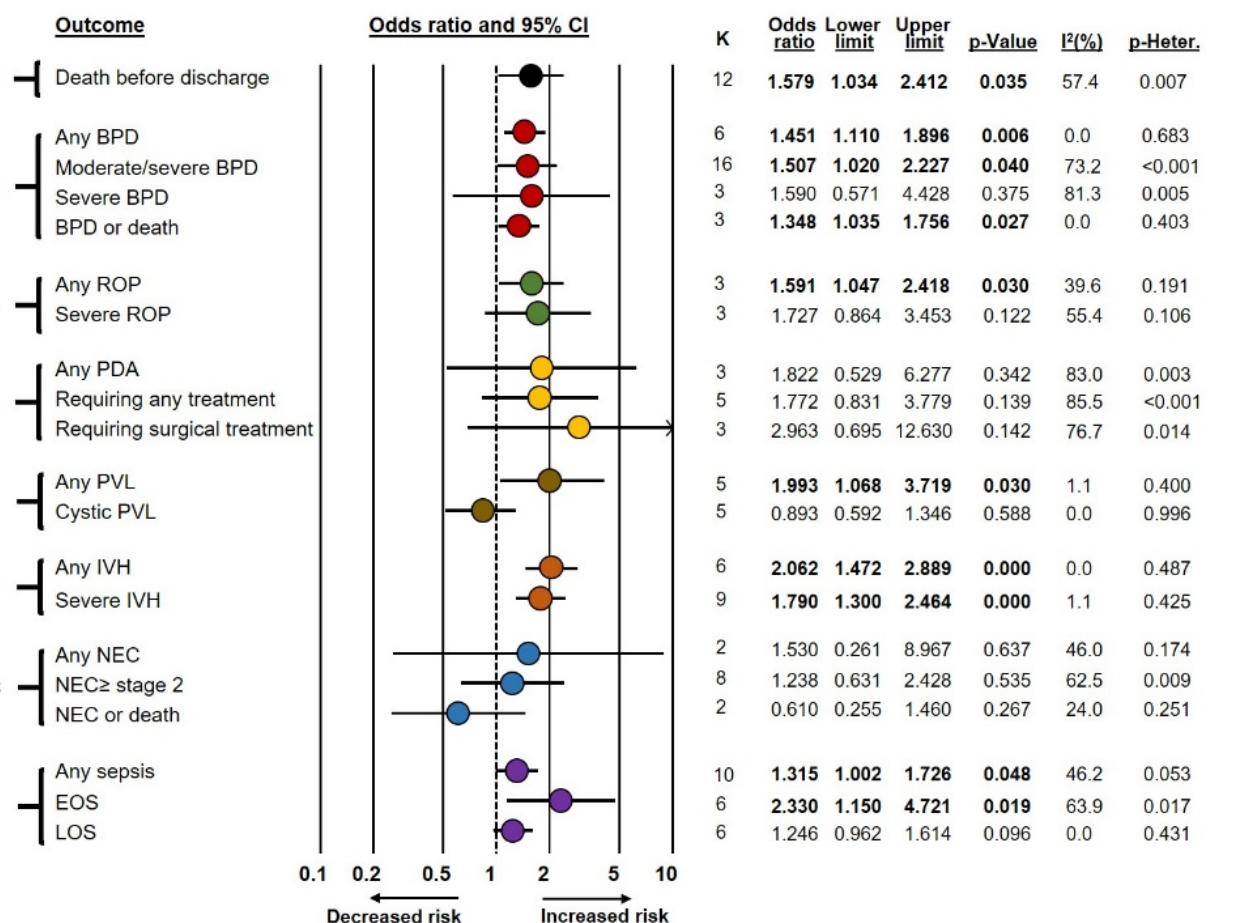
Figure 1. Summary of frequentist random-effects meta-analyses on the association between funisitis and short-term outcomes of prematurity. BPD: bronchopulmonary dysplasia; EOS: early-onset sepsis; IVH: intraventricular hemorrhage; K: number of studies included in the meta-analysis; LOS: late-onset sepsis; NEC: necrotizing enterocolitis; PDA: patent ductus arteriosus; PVL: periventricular leukomalacia; ROP: retinopathy of prematurity.